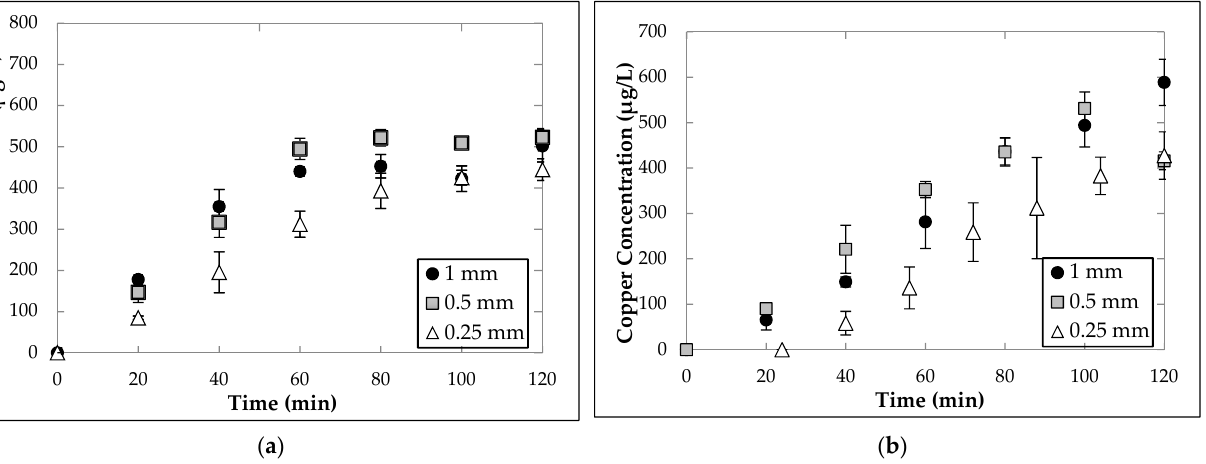
Figure 5. Metal ion concentration in 0.4 L synthetic groundwater as a function of time for wire diameters 0.25 mm, 0.5 mm, and 1 mm in an electrolytic apparatus. ( a ) displays ion release for an apparatus with silver wire, and ( b ) displays release for the same apparatus with copper wire. The average of three trials is shown in each graph, with error bars indicating the standard error between the three trials. The data point for 1 mm at 20 min is an average of two trials due to instrumental error with the third trial. A trendline is included for each type of wire to depict the generally linear relation between metal ion release and time. Variations from the trendline could be attributed to experimental variability.